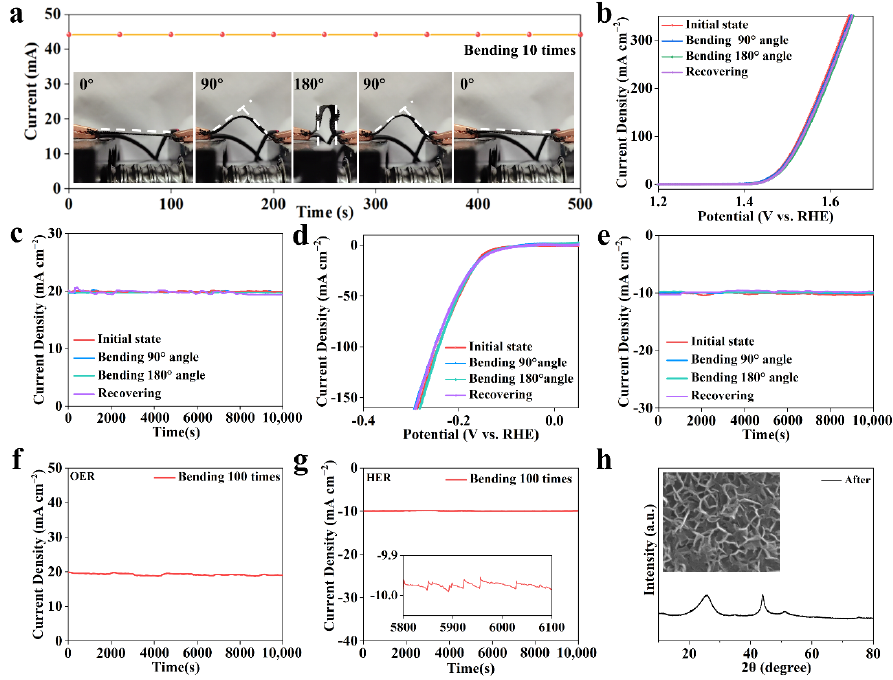
Figure 5. The mechanical flexibility of NiFeCo ‐ LDH/CF. ( a ) I–t curve of the NiFeCo ‐ LDH/CF bent with various curvatures under a constant voltage of 1 V. ( b ) Oxygen evolution reaction (OER) performance of NiFeCo ‐ LDH/CF with various bending states, and ( c ) corresponding long ‐ term stability testing. ( d , e ) Hydrogen evolution reaction performance of NiFeCo ‐ LDH/CF. The long ‐ term stability testing of NiFeCo ‐ LDH/CF after bending 100 times, ( f ) OER, and ( g ) HER (the inset shows a magnified view of local current density). ( h ) The morphology and structure of the NiFeCo ‐ LDH/CF after the long ‐ term stability testing.